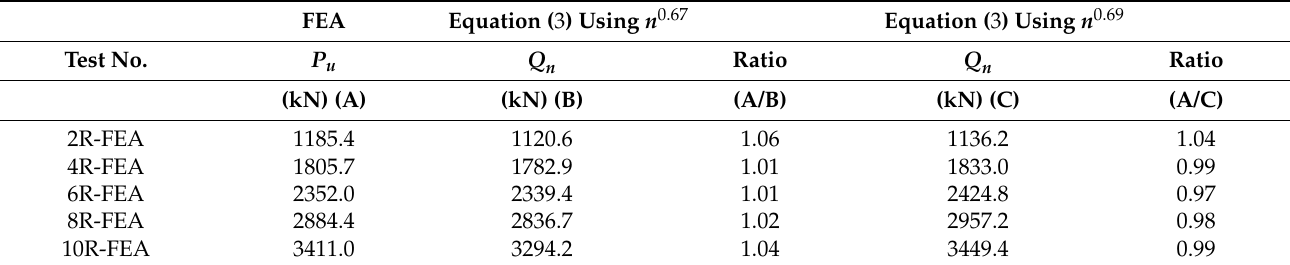
Figure 6. Comparison of numerical and calculated results. Table 18. Biasness of the proposed formula (Equation (3)).